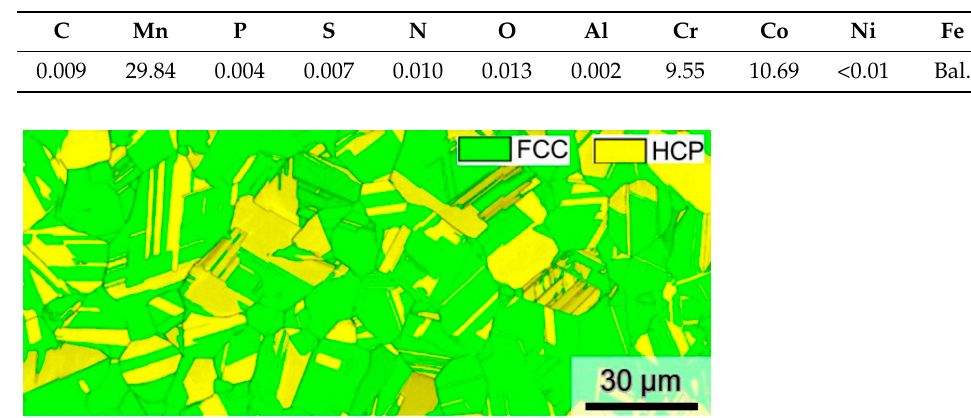
Figure 2. DSC curves of ( a ) cooling and ( b ) heating processes. A tensile specimen with the geometry shown in Figure 3a was taken from the solu- tion-treated bar by spark machining. The specimen geometry was selected to fix our ex- perimental setup for the high-temperature tensile testing with a thermostatic chamber. The tensile test was carried out by using an Instron type tensile machine (Shimadzu, Au- tograph, maximum load = 10 KN). The specimen was deformed until fracture at an initial strain rate of 10 − 4 s − 1 and temperature of 200 °C, which was higher than the A f temperature. The stress–strain curve obtained from the HEA tensile specimen showed approximately 30% uniform elongation (Figure 3b). The fractured specimen contained deformed and un- deformed portions, as shown schematically in Figure 4. Specifically, the grip section and uniformly deformed region highlighted in red in the schematics of the specimens show